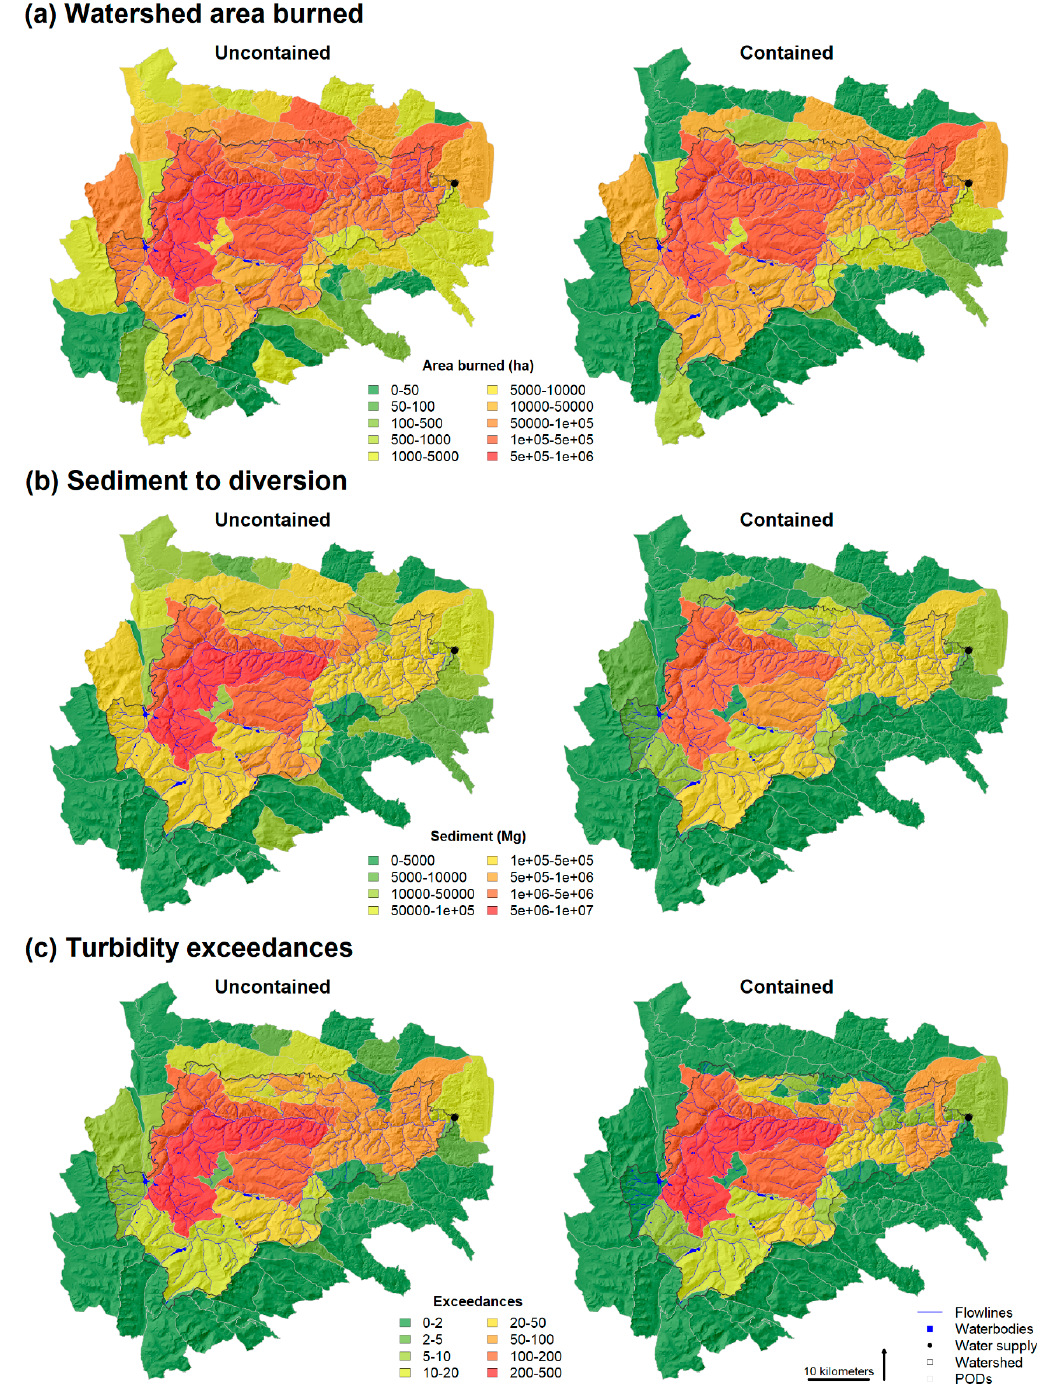
Figure 6. Spatial summary of containment effects on distribution of POD-level indicators of water supply risk for the 2-year rainfall erosivity including: ( a ) watershed area burned, ( b ) first-year post-fire sediment to the diversion, and ( c ) frequency of turbidity exceedances for fires that originate within each POD.